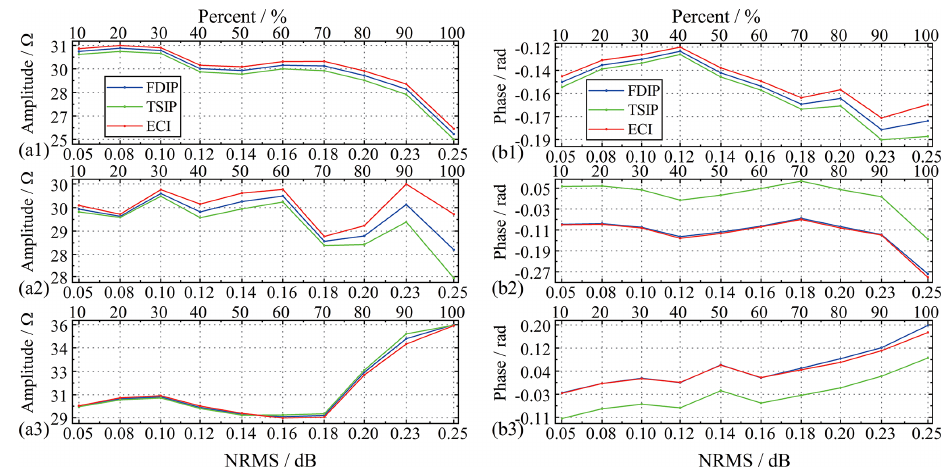
Figure 9. Complex resistivity values at (a1, b1) 80Hz, (a2, b2) 160Hz, and (a3, b3) 320Hz using the three methods.